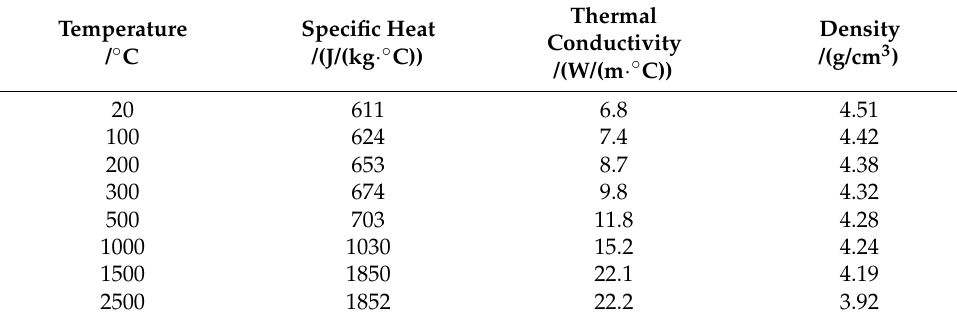
Table 2. Thermal physical properties of materials